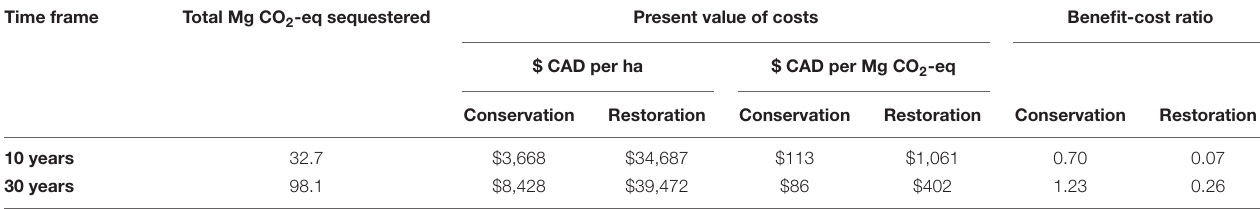
TABLE 2 | Costs and benefits to sequester CO 2 in wetlands in Southern Ontario over 10- and 30-year time frame in 2021 $ CAD. Time